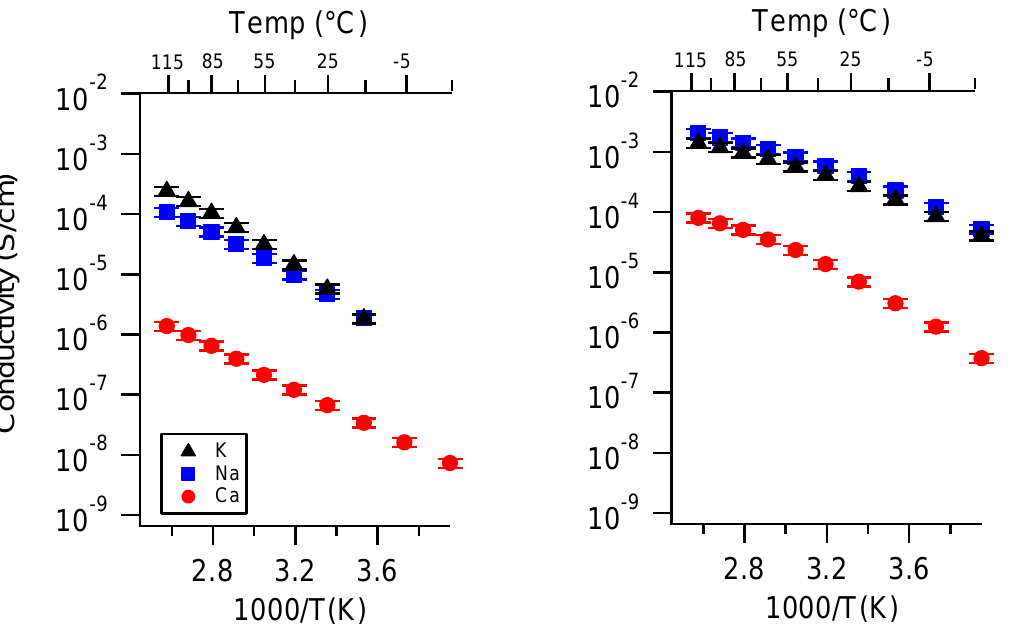
Figure A9. Conductivity as a function of cation for PEGDMA1000_high_SSM (left) and PTHFDA1000_high_STFSI (right) SIPEs swelled with ECPC. Temperatures ranged from − 20 °C to 115 °C.